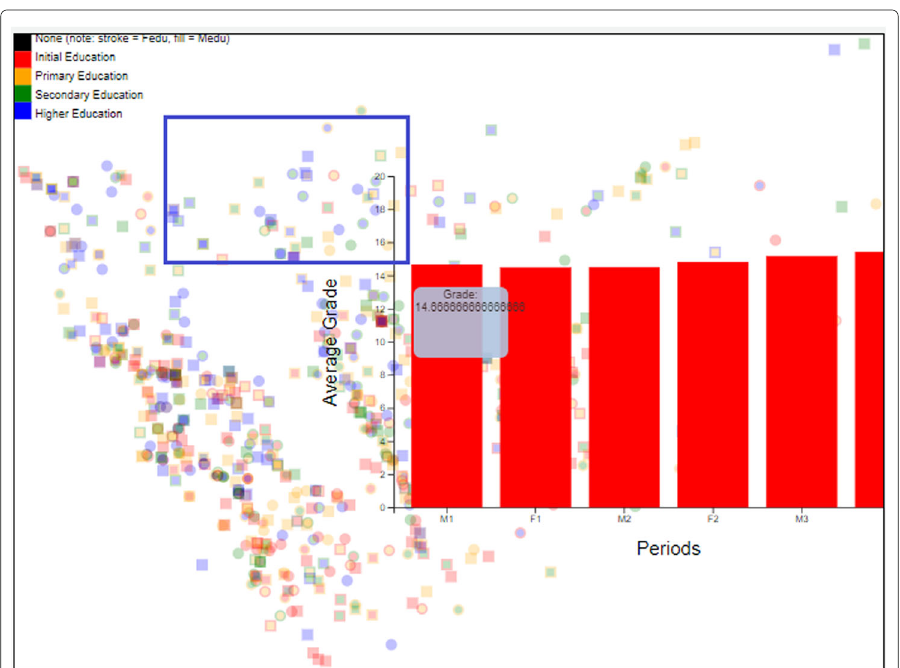
Fig. 24 Isomap for "Portuguese" class, all periods, considering both genders